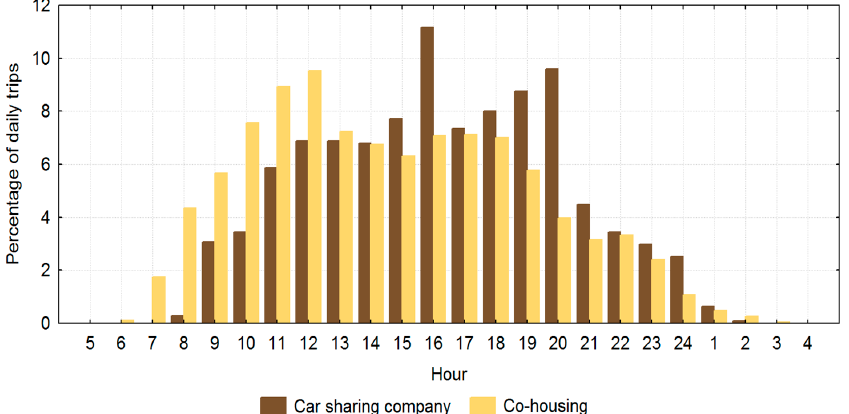
Figure 2. Driving behavior—distribution of daily trips.